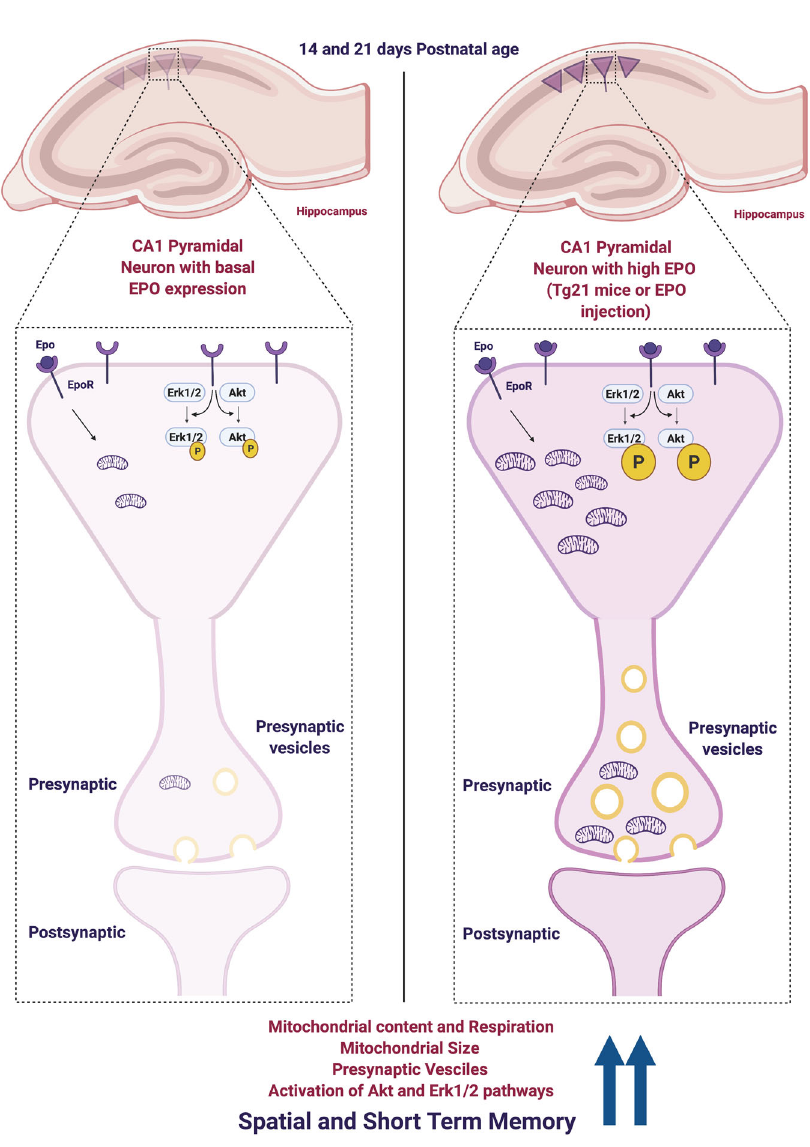
Fig. 8 Illustrative summary of proposed EPO functions in hippocampal CA1 pyramidal cells at postnatal ages P14 and P21. Hippocampal CA1 pyramidal cells are represented by triangles. When EPO-EPOR binding increases (e.g., Tg21 animals or WT mice treated with high doses of EPO), increased phosphorylation of Erk1/2 and AKT precedes an increase in mitochondria content, size, and function. More mitochondria are also observed in presynaptic terminals, along with an increase in vesicle numbers. As a result, animals with greater hippocampal respiratory potential show enhanced spatial learning and short-term memory at adulthood. (Figure created with